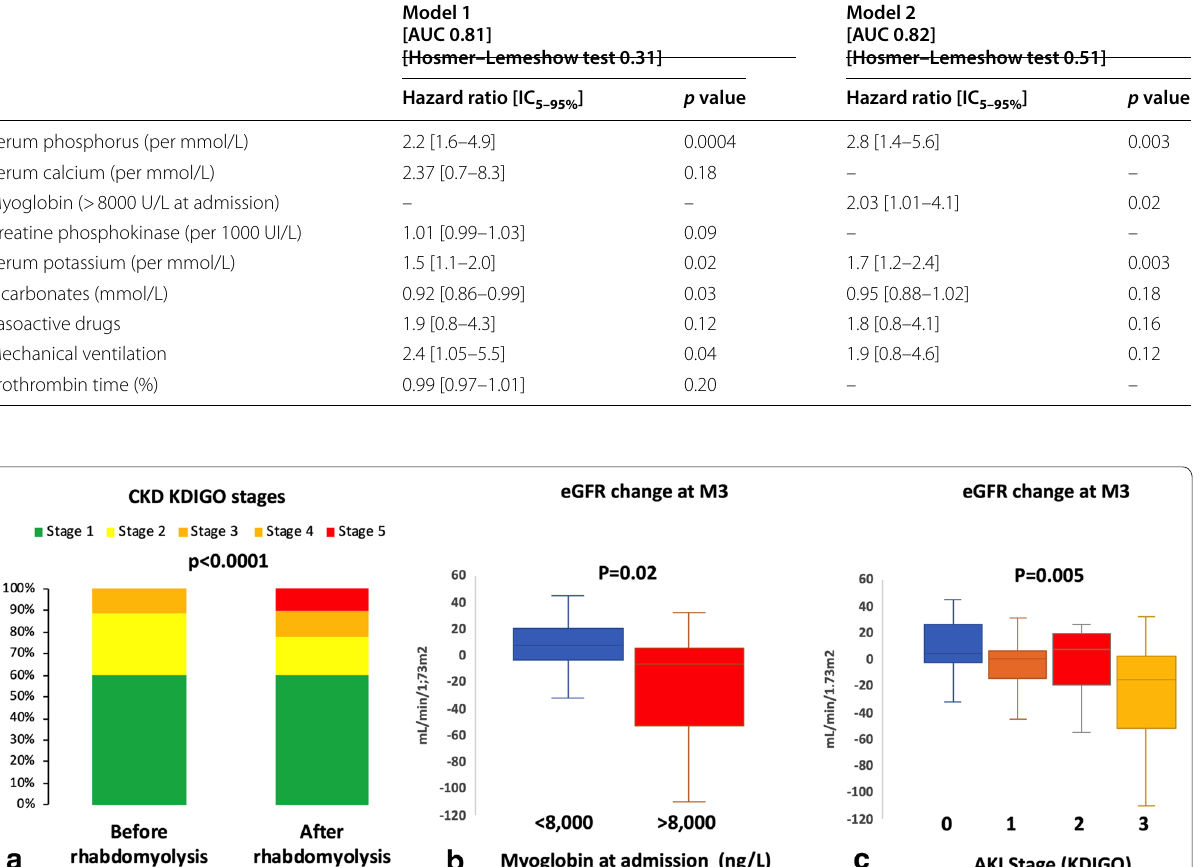
Fig. 2 Risk of acute kidney injury to chronic kidney transition after an episode of severe rhabdomyolysis. a CKD KDIGO stages before and after (month 3) severe rhabdomyolysis. b , c Change of the estimated glomerular filtration rate 3 months after a severe rhabdomyolysis (eGFR at month 3 minus basal eGFR) according to the serum level of myoglobin at admission ( b ) and the severity of the acute kidney injury ( c